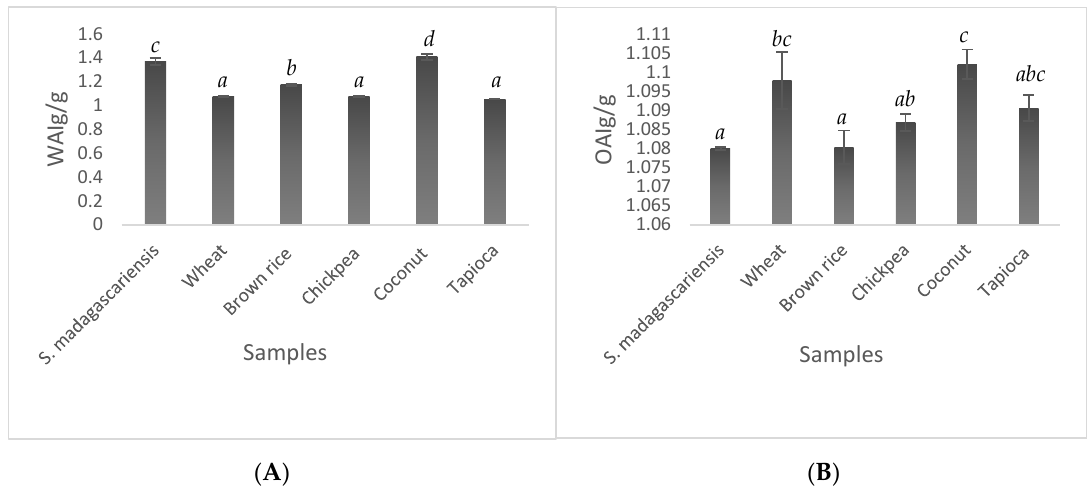
Figure 1. Water ( A ) and oil ( B ) absorption index of Strychnos madagascariensis seed flour compared to five commercial flours. The error bars indicate the standard deviations of each of the samples, with Least Significant Di ff erence values of 0.0248 and 0.00737 for water absorption index (WAI) and oil absorption index (OAI), respectively. Bars with the same letters above them show no significant di ff erences ( p < 0.001).